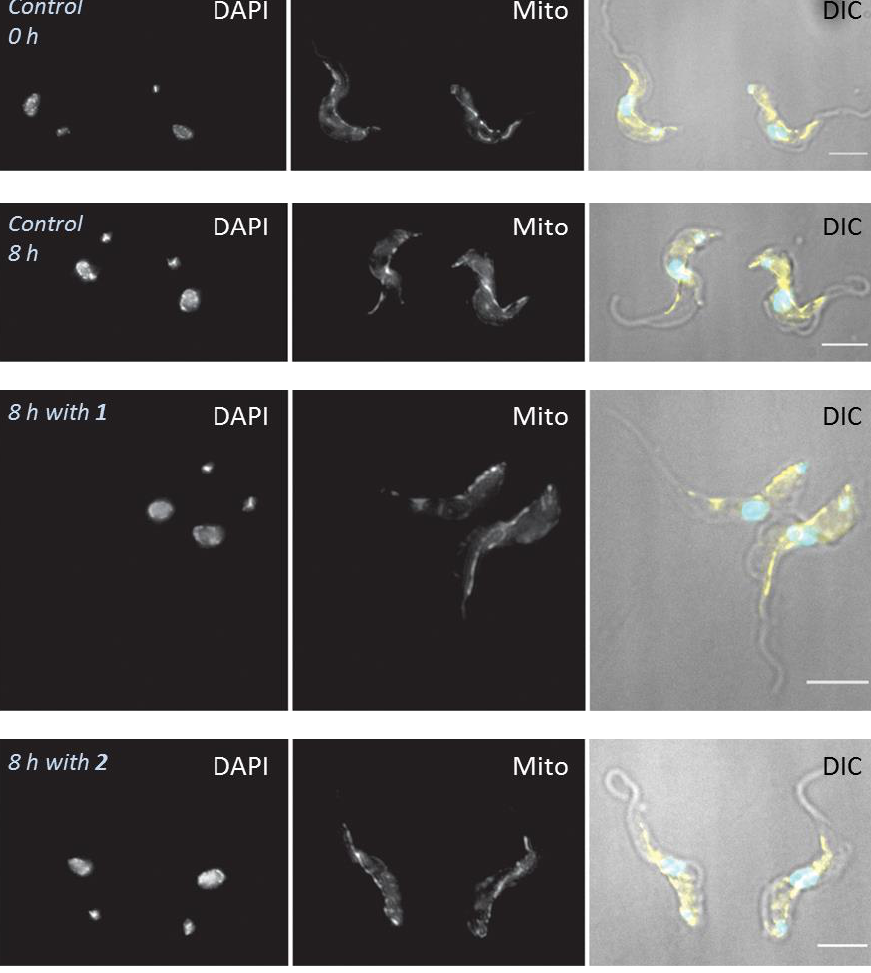
Figure 6. High-resolution fluorescence microscopy of individual cells observed with wide-field deconvolution fluorescence microscope. In the overlay, cyan is DAPI, yellow is MitoTracker. Representative images, taken of random cells (blind study). Scale bars are 5 µm.